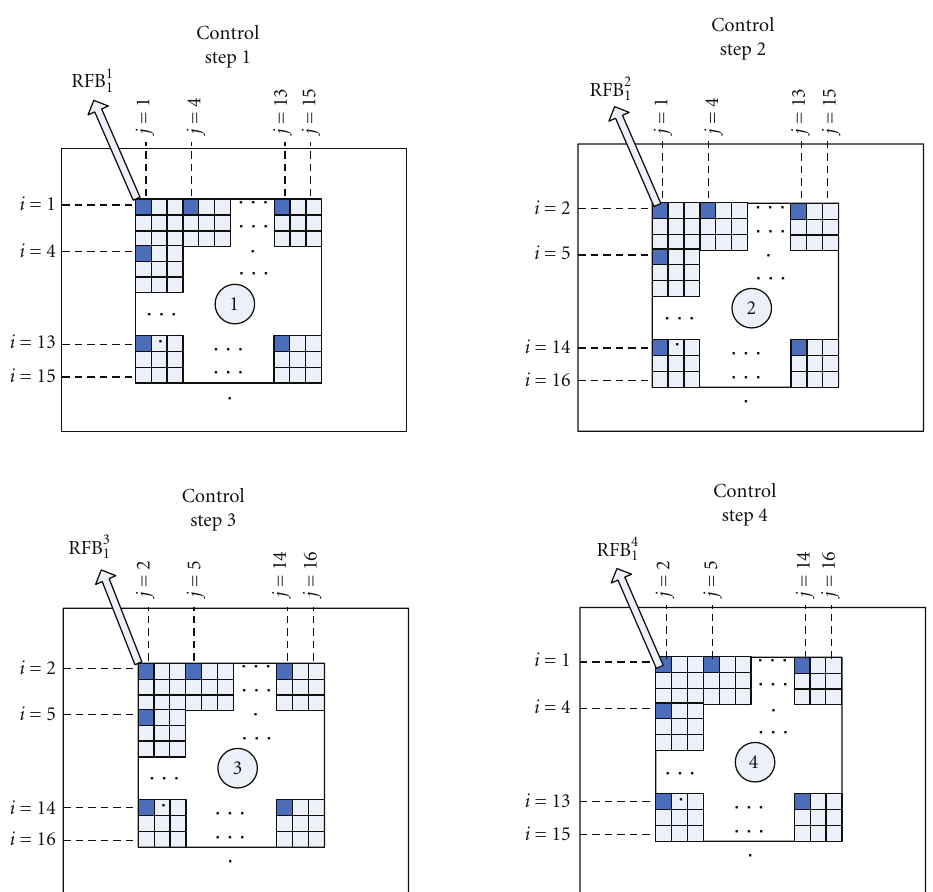
Figure 7: Illustration of candidate blocks and three types of data flow amongst candidate blocks over multiple control